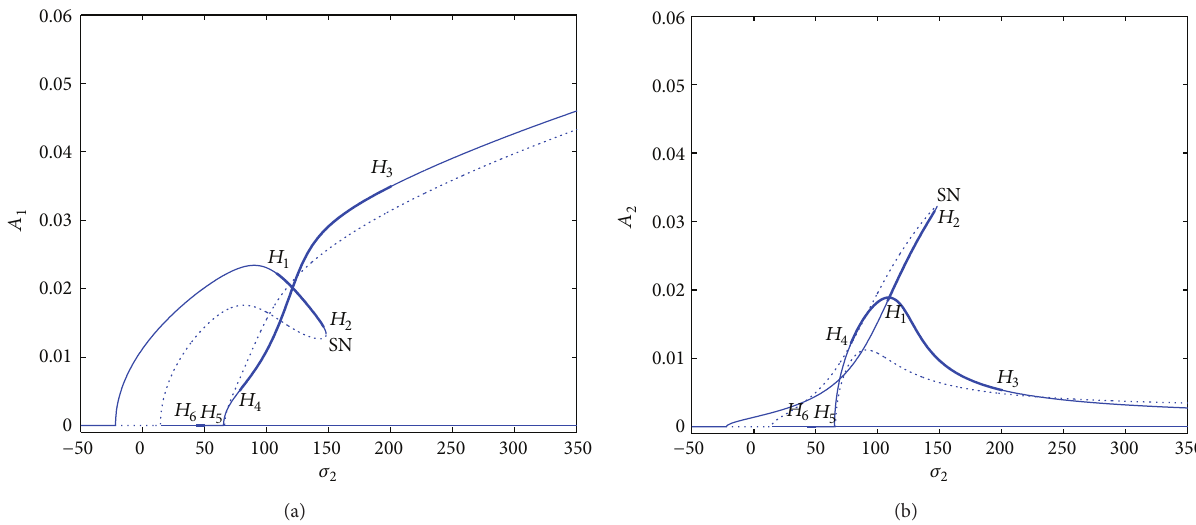
Figure 6: Frequency response curves for the (a) first mode and (b) second mode when the first mode is parametrically excited for the system parameters 𝛼 = 0.001 , 𝜇 = 0 , V 1 = 10 , V 𝑙 = 40 , and 𝜎 1 = 92.39